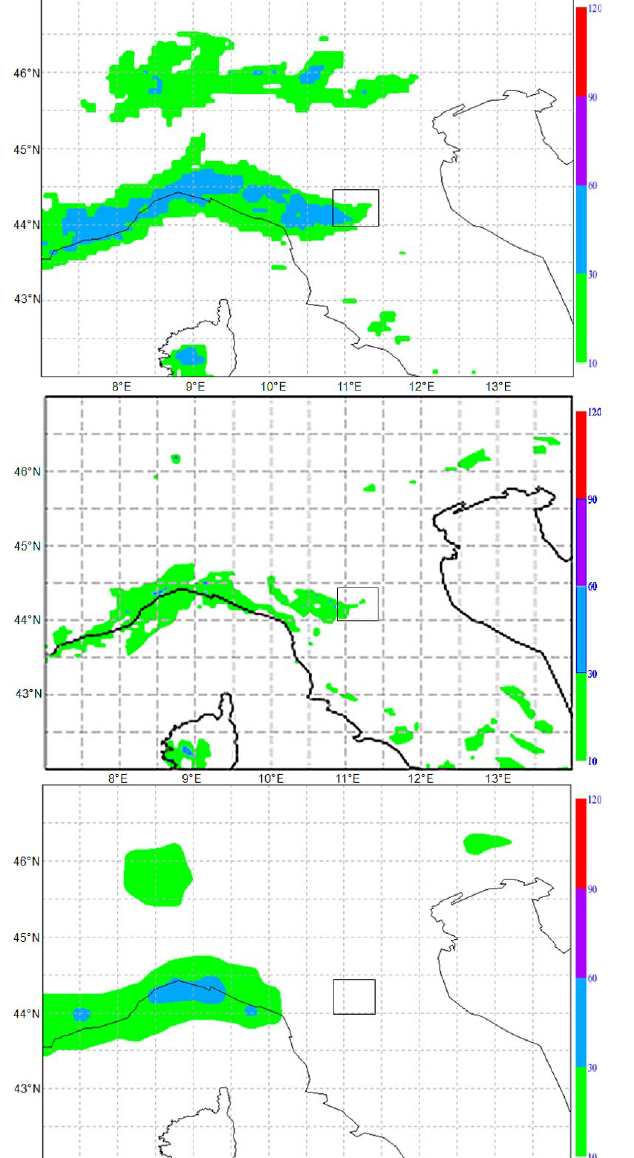
Figure 3. Probability of precipitation exceeding 20mm / 6h forecast by (from top to bottom) multi-model, COSMO-LEPS and ECMWF EPS, at 00:00UTC, 30 November 2008. Simulations are initialized at 12:00UTC, 26 November